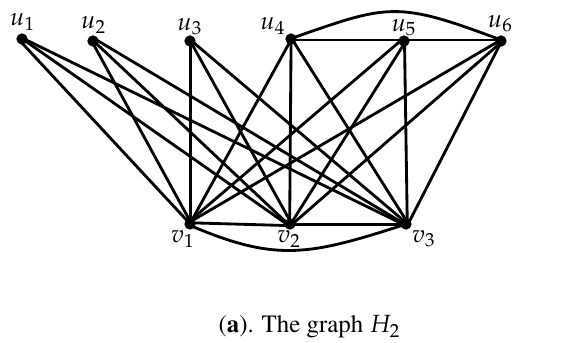
Figure 2. The graph H 2 and its N 2 -embedding.